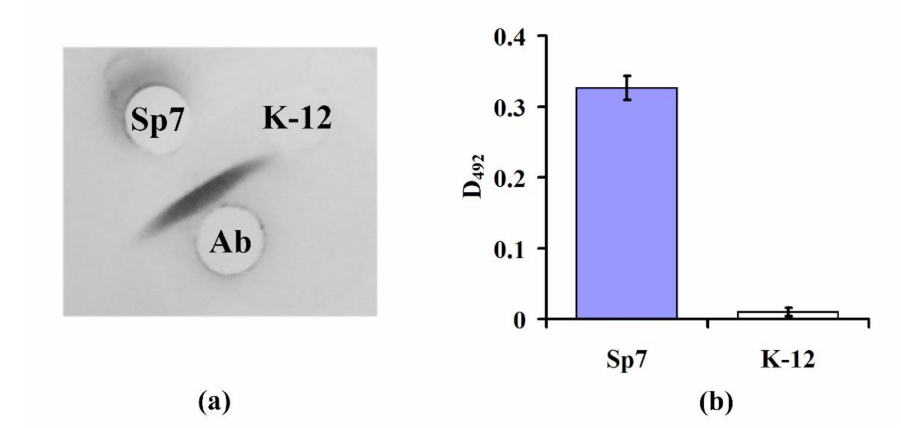
Figure 5. Results of the immunodi ff usion assay ( a ) and ELISA ( b ) of strains A. brasilense Sp7 and E. coli K-12 with the antibodies against A. brasilense Sp7 O-antigen (Ab). For ELISA, the optical density of the enzyme reaction for a concentration of 10 6 cells / mL is